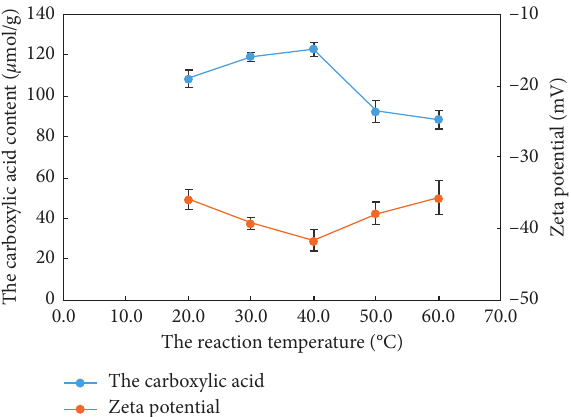
Figure 3: The effect of reaction temperature on the Fenton oxidation efficiency.